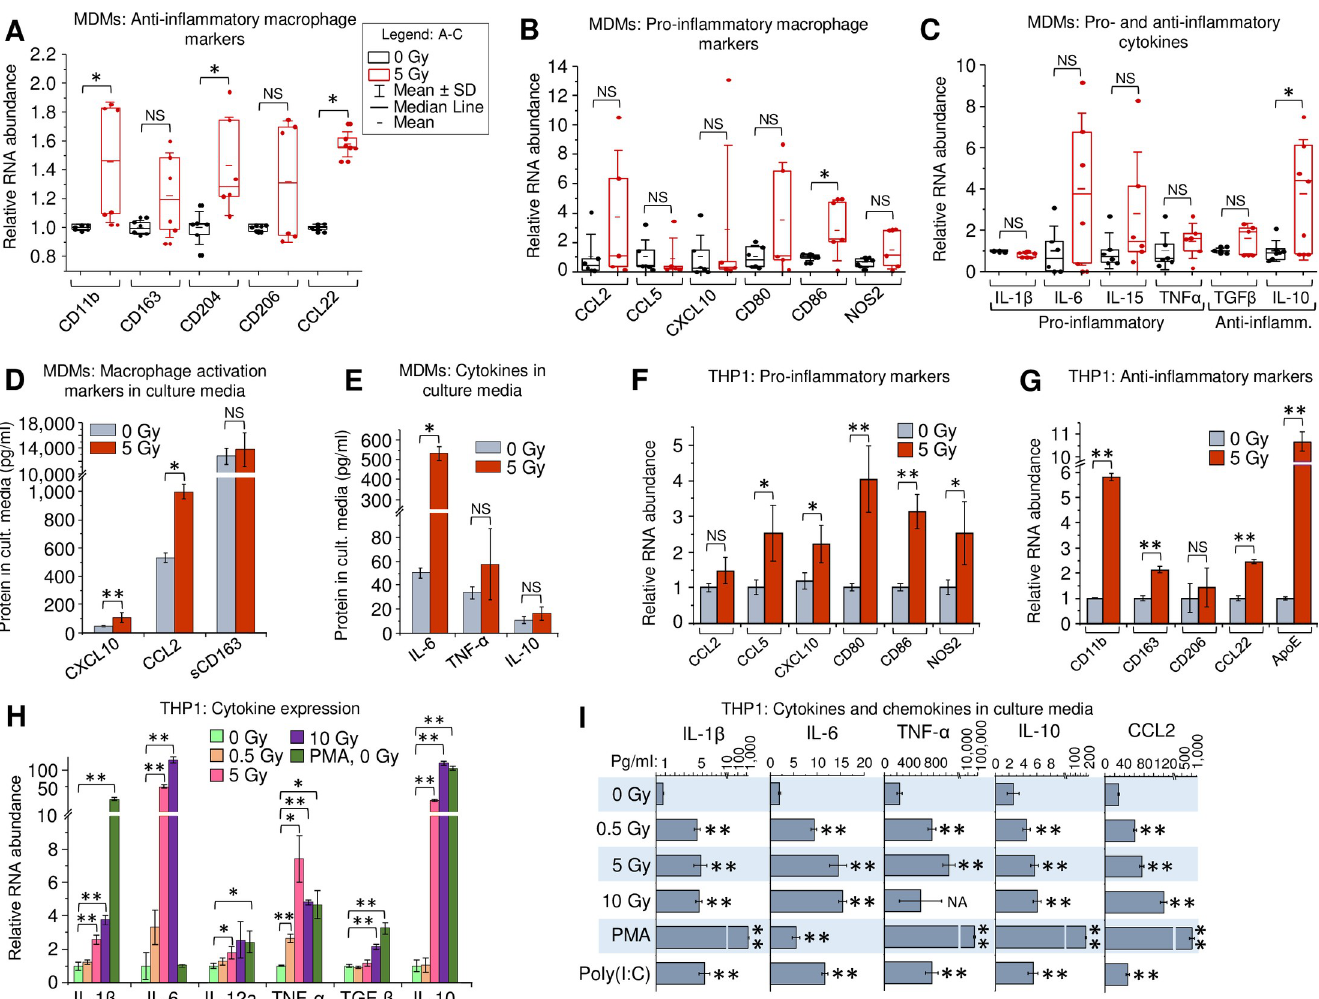
Fig 1. Gamma radiation enhances expression of activation markers in primary human MDMs and THP1 monocytes. ( A-C ) Expression of macrophage anti- inflammatory markers ( A ), pro-inflammatory markers ( B ), and major cytokines ( C ) in primary human MDMs, 48h post-irradiation. MDMs were differentiated from PBMCs, isolated from 6 donors, by treatment with M-CSF and exposed to 5Gy γ IR; box plots of RT-qPCR measured expression of n = 6 is shown. � p < 0.05, paired Wilcoxon test. ( D and E ) Protein concentrations of soluble macrophage activation markers CXCL10, CCL2 and sCD163 ( D ) and cytokines IL-6, TNF- α , and IL-10 ( E ) in culture medium of primary MDMs, 48h post-irradiation. Error bars indicate ± SD of three independent biological replicates; � p < 0.05, �� p < 0.01, panel D and below–paired t test. ( F and G ) Expression of macrophage pro-inflammatory ( F ) and anti-inflammatory ( G ) markers in human monocytic cells THP1 48h after exposure to γ IR. Error bars indicate ± SD of four independent biological replicates. ( H ) Expression of cytokines in THP1 cells, 48h after γ IR. Cells were exposed to indicated γ IR doses; RT-qPCR analysis was performed with primers specific for indicated cytokines. Error bars indicate ± SD of 4 independent biological replicates. ( I ) Quantitation of proinflammatory (IL-1 β , IL-6, TNF- α , CCL2) and anti-inflammatory (IL-10) cytokines in culture media of γ IR-exposed THP1 cells using Luminex multiplex immunoassay, 48h after γ IR, PMA (20 nM) or poly(I:C) (2 μ g/ml) treatment. Error bars indicate ± SD of three independent biological replicates; �� p < 0.01 vs 0 Gy. For panels F to I: � p < 0.05, �� p < 0.01, NS non-significant.